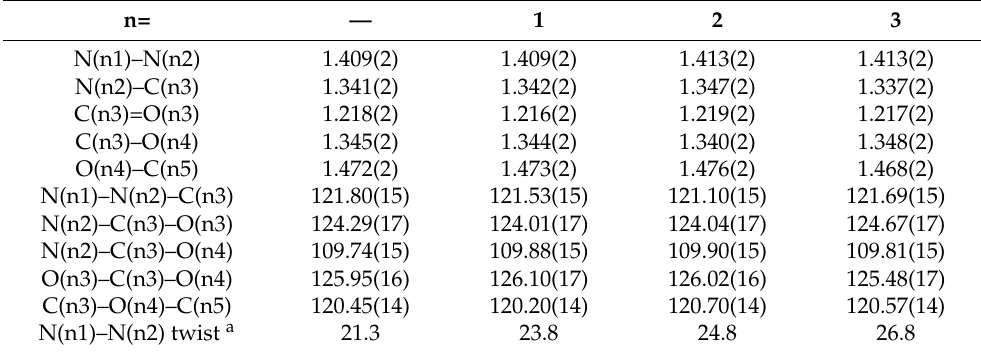
Figure 1. Molecular structure of 1 , showing the four independent molecules with anisotropic dis- placement ellipsoids drawn at the 50% probability level and the numbering system used. Table 1. Comparison of selected geometric parameters between the 4 independent molecules of 1 (Å, °).